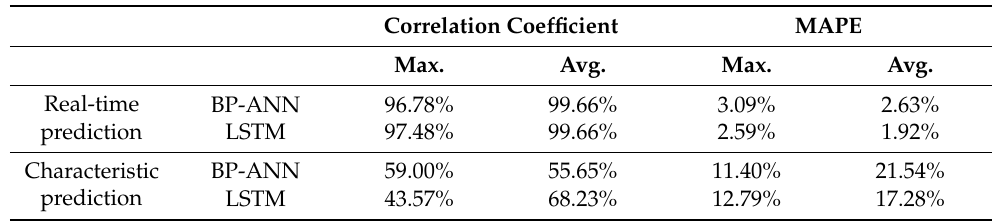
Table 3. The correlation coefficient and MAPE assessment indices for daily RH prediction results of two models using BP-ANN and LSTM techniques.